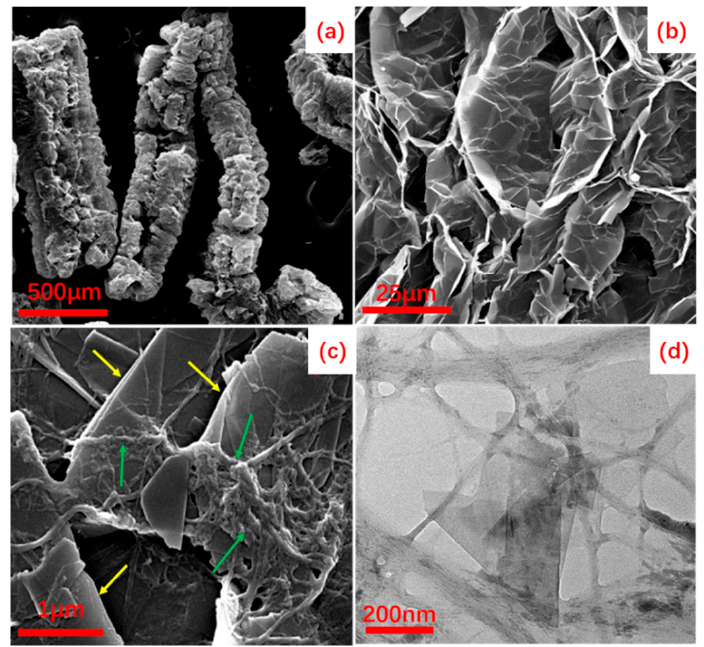
Figure 2. ( a , b ) SEM images of EG; ( c ) SEM image of CNFs-FLG; ( d ) TEM image of CNFs-FLG. The green and yellow arrows indicate CNFs and FLG, respectively.